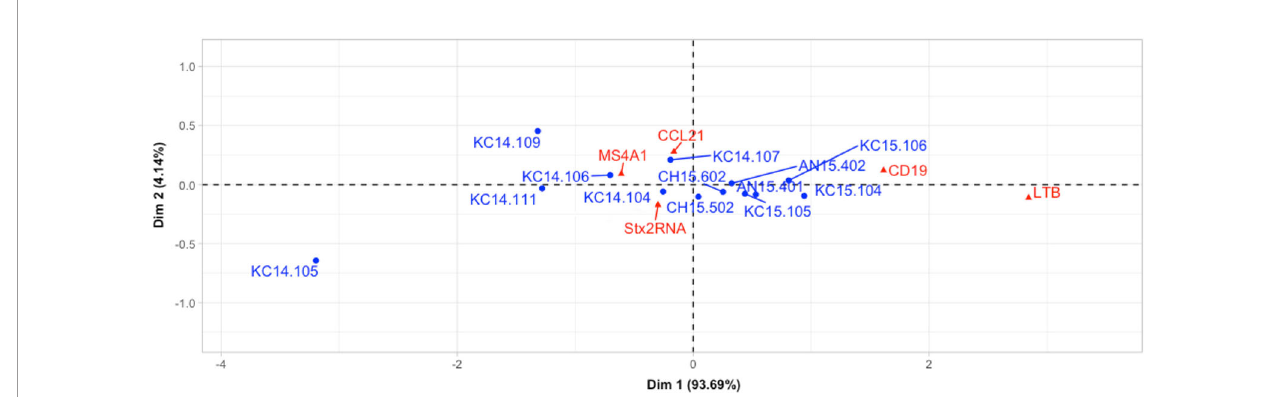
FIGURE 2 | Assessment of associations between host immune gene expressions and Stx2+ samples using correspondence analysis. Red triangles and blue dots refer to host genes and Stx2+ samples, respectively. For example, “ AN14.105 ” means the number of this sample is 105, breed is Angus, and was collected in 2014.